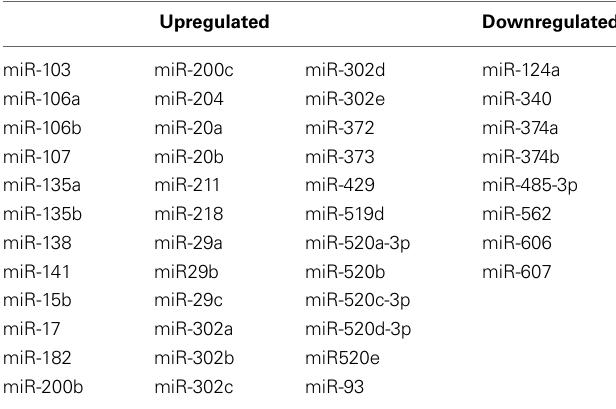
Table 1 | Genes with strong disease-associations that exhibit altered expression in maternal mPFC.